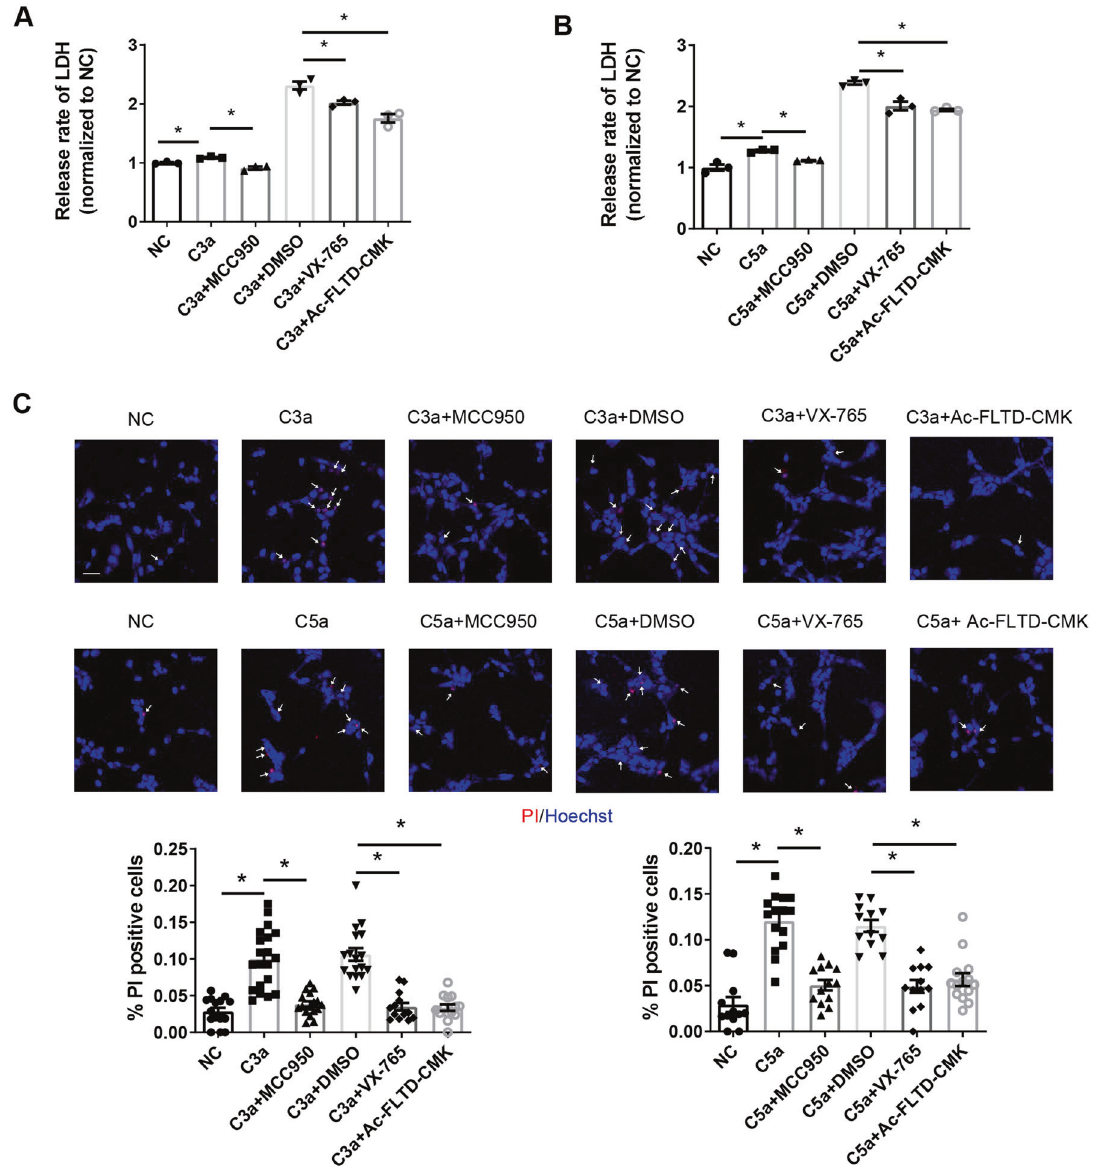
three independent experiments. * p <